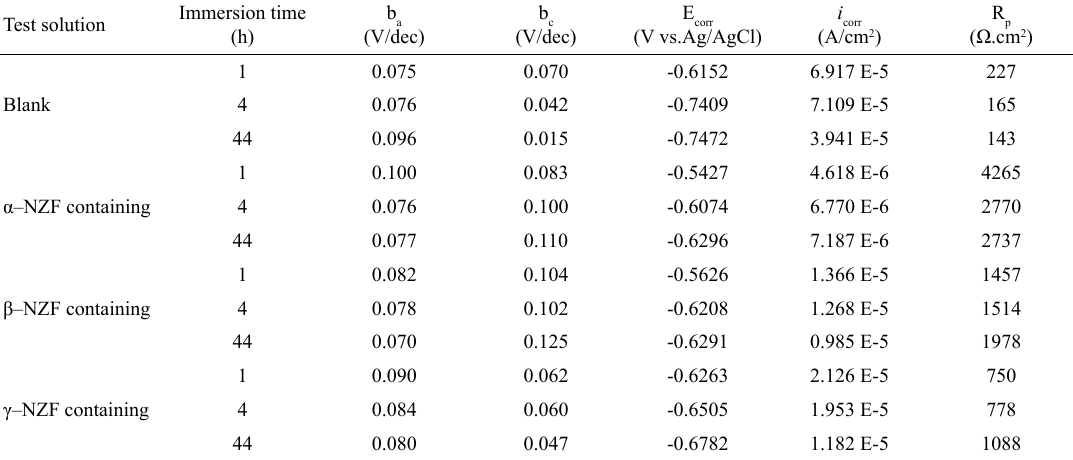
Figure 4. Polarization curves of steel samples after 1 (◊), 4 (Δ), and 44 h (□) immersion in 3.5 wt. % NaCl solution containing: (a) nothing, (b) α-NZF, (c) β-NZ,F and (d) γ-NZF. Table 3. Variation of corrosion kinetic parameters of steel samples after 1, 4, and 44 h immersion in 3.5 wt. % NaCl solution without (blank) and with α–, β–, and γ–NZF